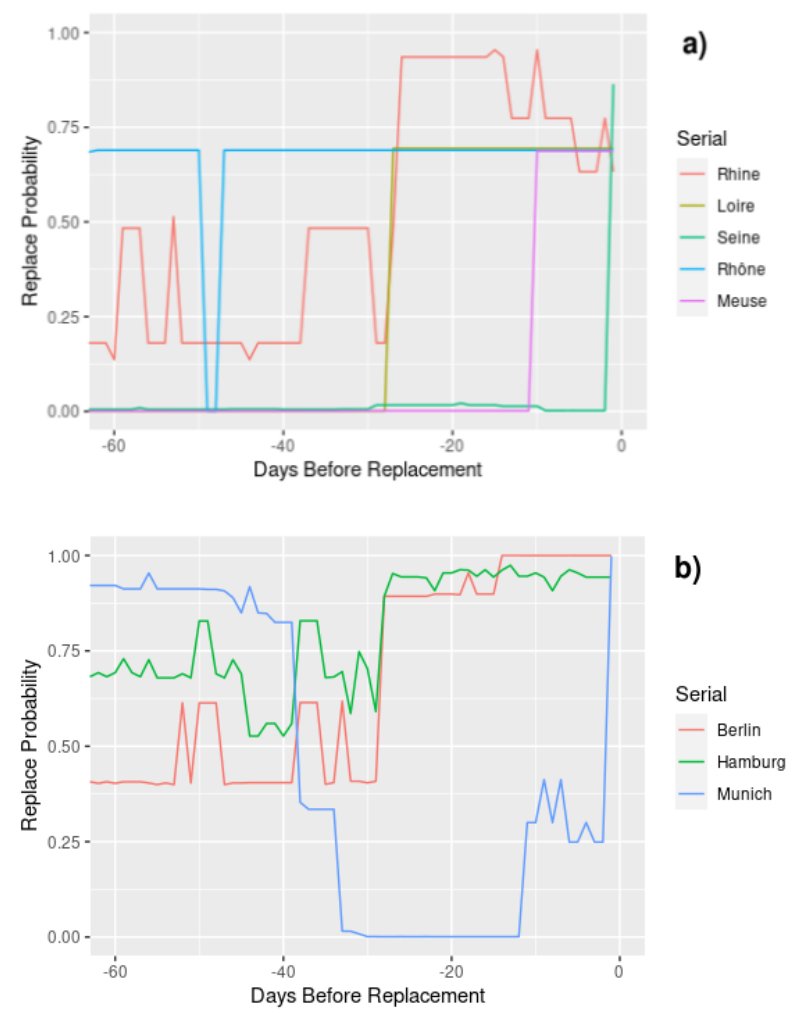
Figure 7. Validation of the Ischia ( a ) and Ventotene ( b ) Hard Disk